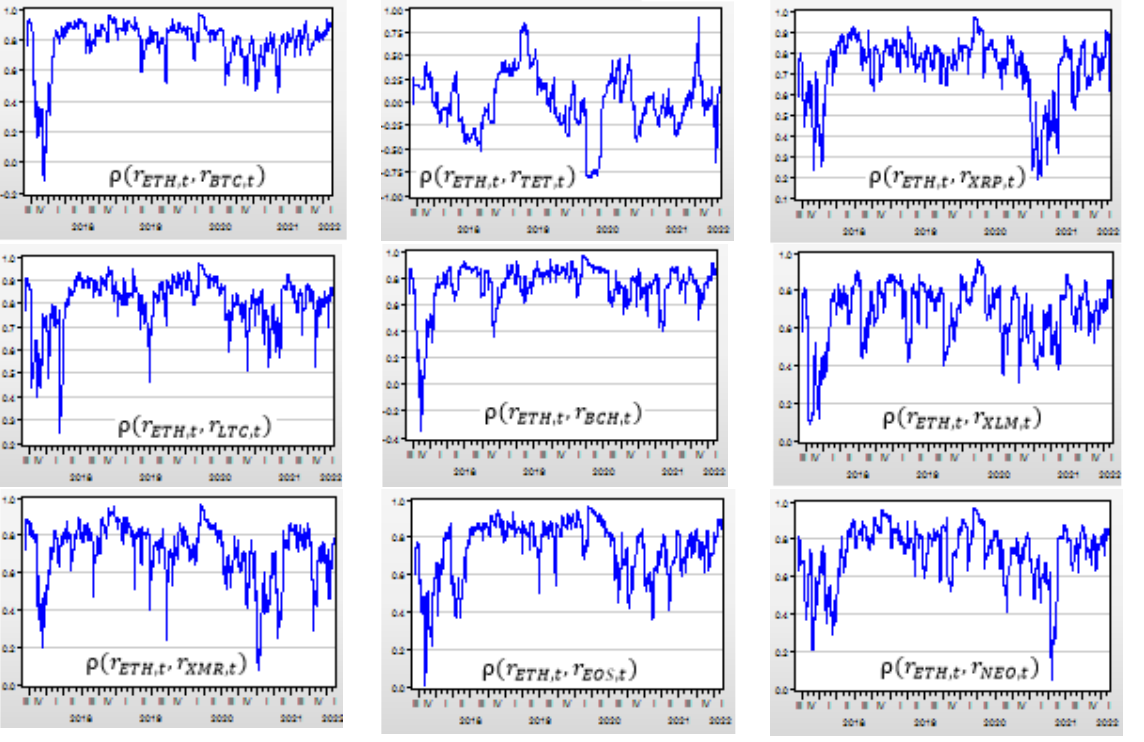
Figure 4. Curves of the DCC between Ethereum and the other eight cryptocurrencies for the full period.